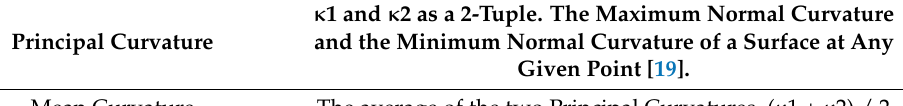
Table 7. Different curvature metrics for a 2D surface embedded in 3D space. κ 1 and κ 2 as a 2-Tuple. The Maximum Normal Curvature Principal Curvature and the Minimum Normal Curvature of a Surface at Any Given Point [19]. Mean Curvature The average of the two Principal Curvatures, ( κ 1 + κ 2) / 2 Gaussian Curvature The signed product of the two Principal Curvatures, κ 1 * κ 2 A new term coined by [22], which is the sum of the absolute Absolute Curvature values of the Principal Curvatures: | κ 1| + | κ 2| The magnitude of the Gaussian Curvature, used presently at Absolute Gaussian Curvature